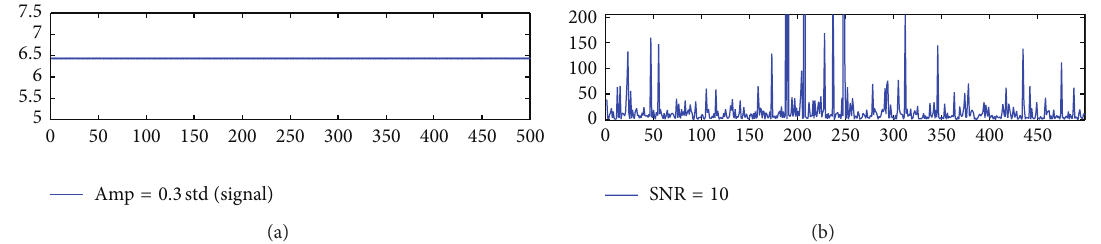
Figure 2: The predefined constant amplitude (0.3 std (signal)) (a) and the proposed amplitude algorithm (PIEEMD with SNR = 10)